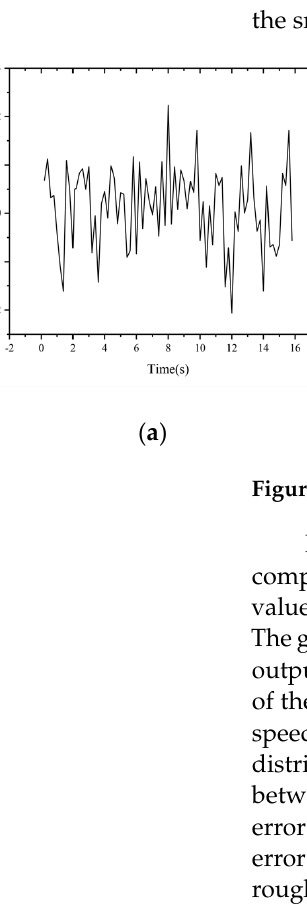
Figure 17. Depth− standard value vs. predicted value. ( a ) 20 mm/s. ( b ) 40 mm/s. ( c ) 60 mm/s.